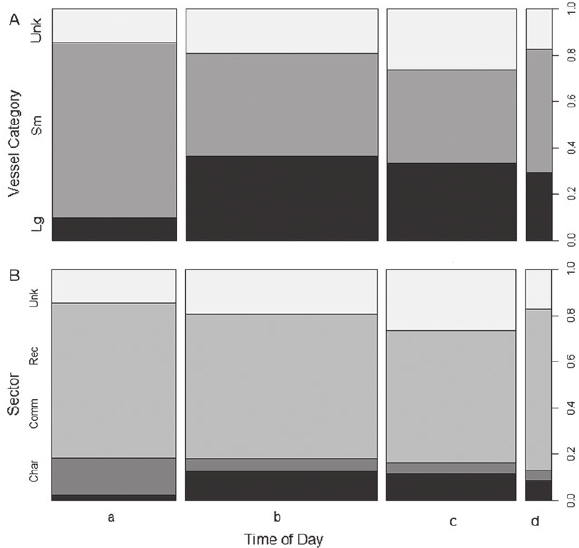
Fig. 4. – Association of (A) vessel category and (B) sector to de- tected vessel presence by time of day off San Juan, Puerto Rico. The rectangle height determines the frequency of (A) vessel category and (B) sector association; width determines the frequency of time of day. (A) Labelled from top to bottom (Unk: vessel unclassifiable; Sm: small vessel; Lg: large vessel) (B) Labelled from top to bottom (Unk: vessel unclassifiable; Rec: recreational; Comm: known and likely commercial vessels; Char: known charter vessels); (time of day = a, early am (0530-0859); b, late am (0900-1229); c, early pm (1230-1559); d, late pm